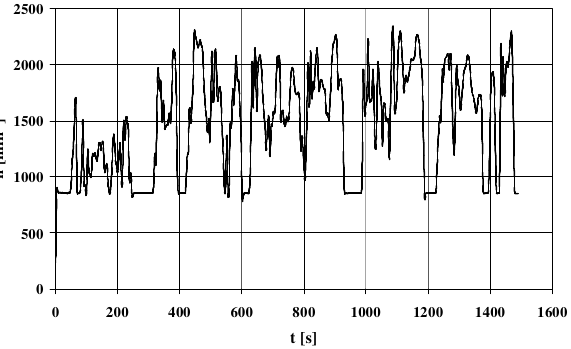
Fig. 5. Average engine speed value in the NEDC and Malta tests